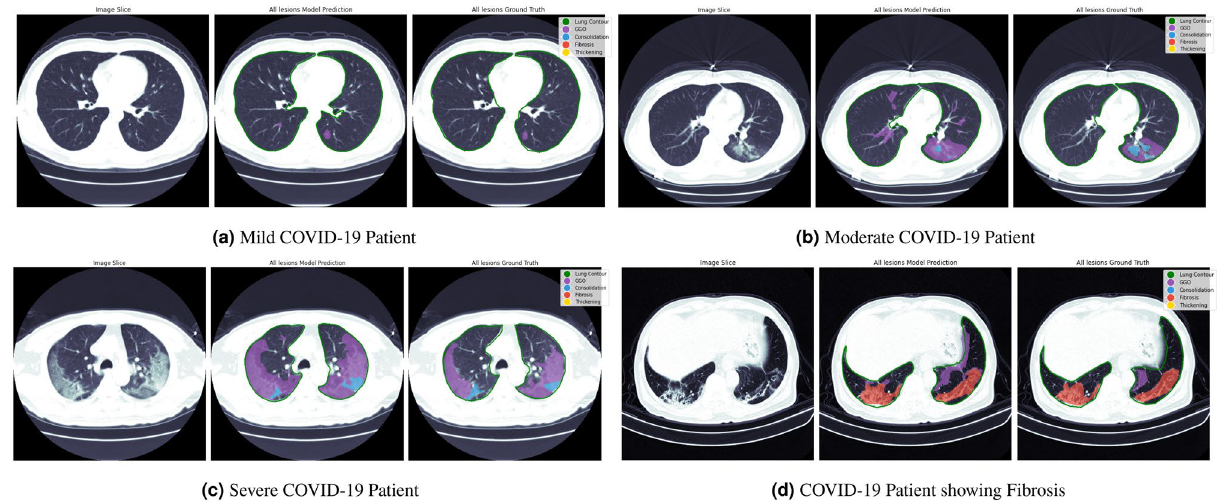
Figure 3. Qualitative results from our proposed lung segmentation and multitask segmentation network on COVID-19 patients presenting different levels of disease severity. For every sub-figure the first image represents the input CT slice image, the second image represents our model prediction from all different lesions and the last image represents the segmentation ground truth obtained from expert radiologists. ( a ) Model predictions on a patient with mild novel COVID-19 pneumonia with CT findings of GGO (purple), ( b ) Model predictions on a patient with moderate novel COVID-19 pneumonia with CT findings of both GGO (purple) and consolidation (blue), ( C ) Model predictions on a patient with severe novel COVID-19 pneumonia CT findings of both GGO (purple) and consolidation (blue), ( d ) Model predictions on a patient presenting severe pulmonary fibrosis (red) and GGO